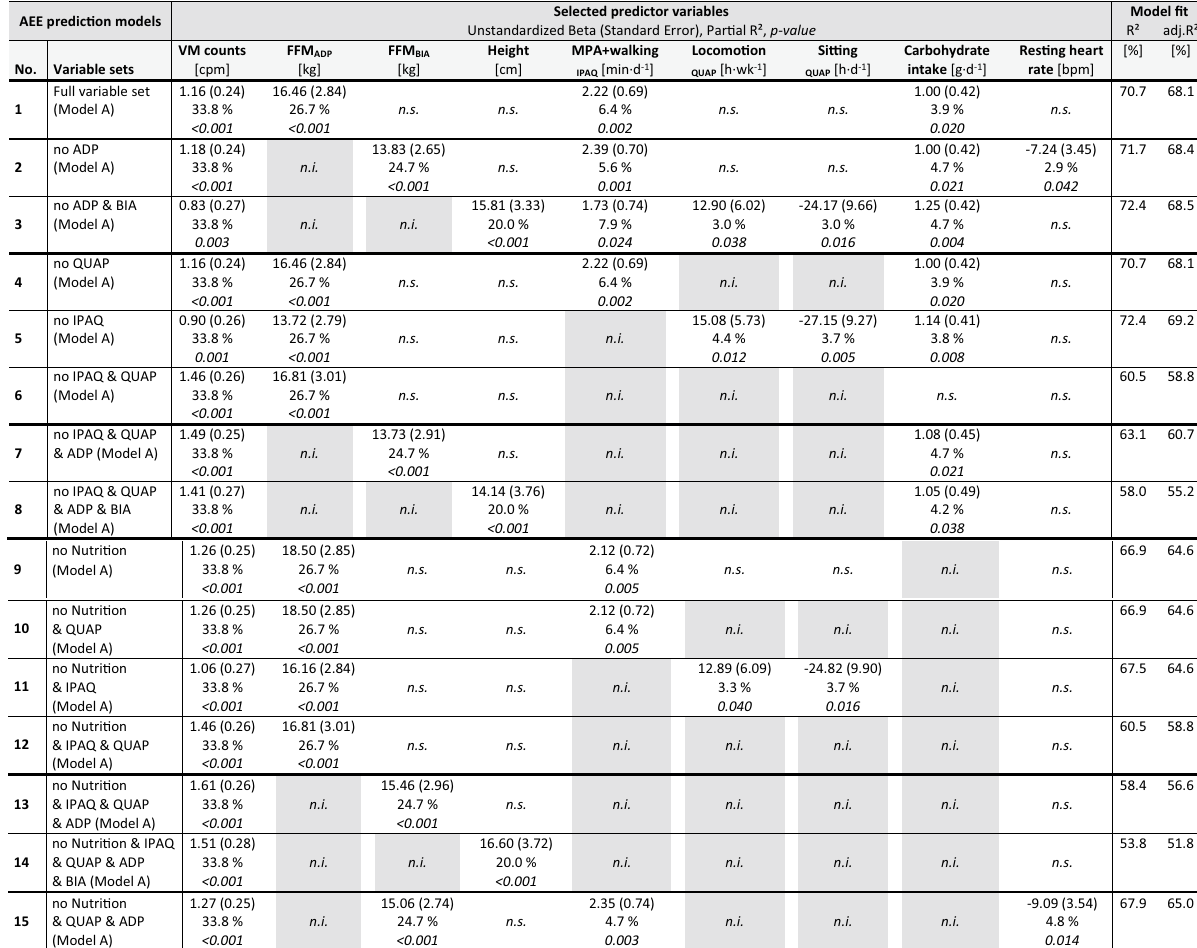
Table 4. AEE prediction models derived from stage II stepwise selection regression using accelerometer variable VM counts and full or reduced variable sets (n = 49). Predictors were selected applying stepwise regression with p-value limits of 0.05 (Model A). Gray-shaded variables were not offered for selection in the specific setting. More details and the results of the sensitivity analyses revealing additional models are shown